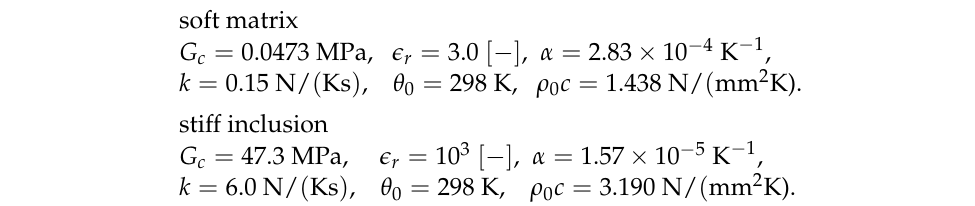
Table 1. Parameters for the finite element simulations.